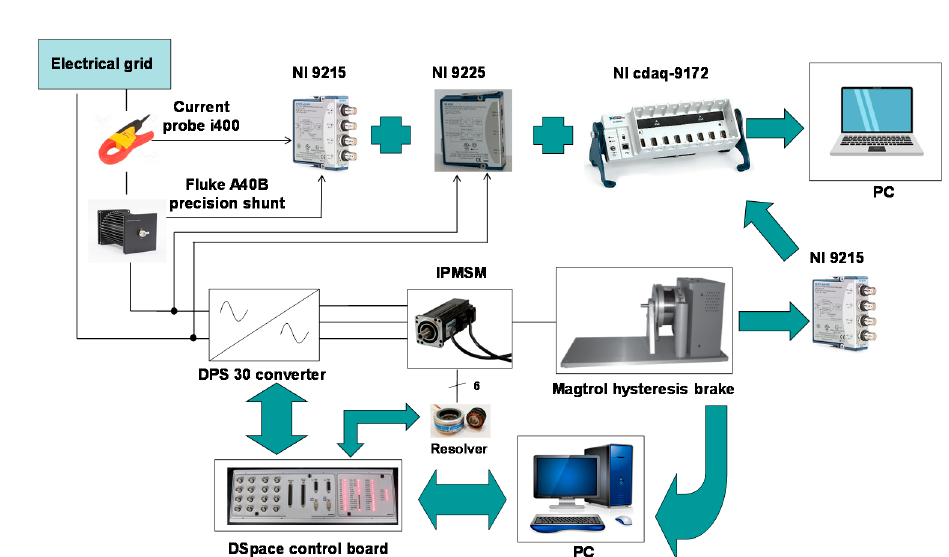
Table 2. Main features of the Magtrol hysteresis brake.